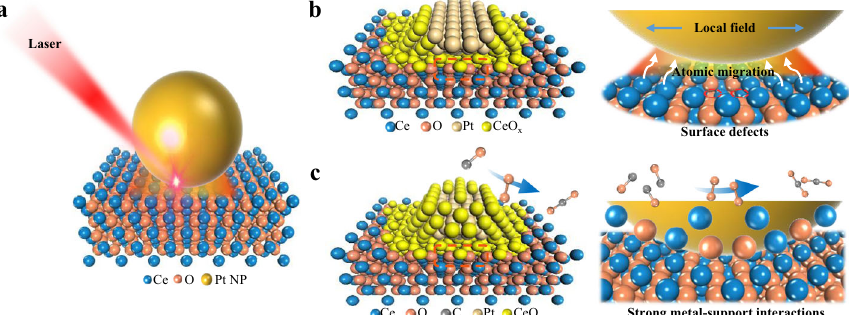
Fig. 1 Schematic of the ultrafast laser-induced SMSI in Pt/CeO 2 . a Pt/CeO 2 nanostructure irradiated at ultrafast laser. b The surface defects and metastable CeO x migration induced by local fi eld. c The high catalytic stability obtained from the laser-induced